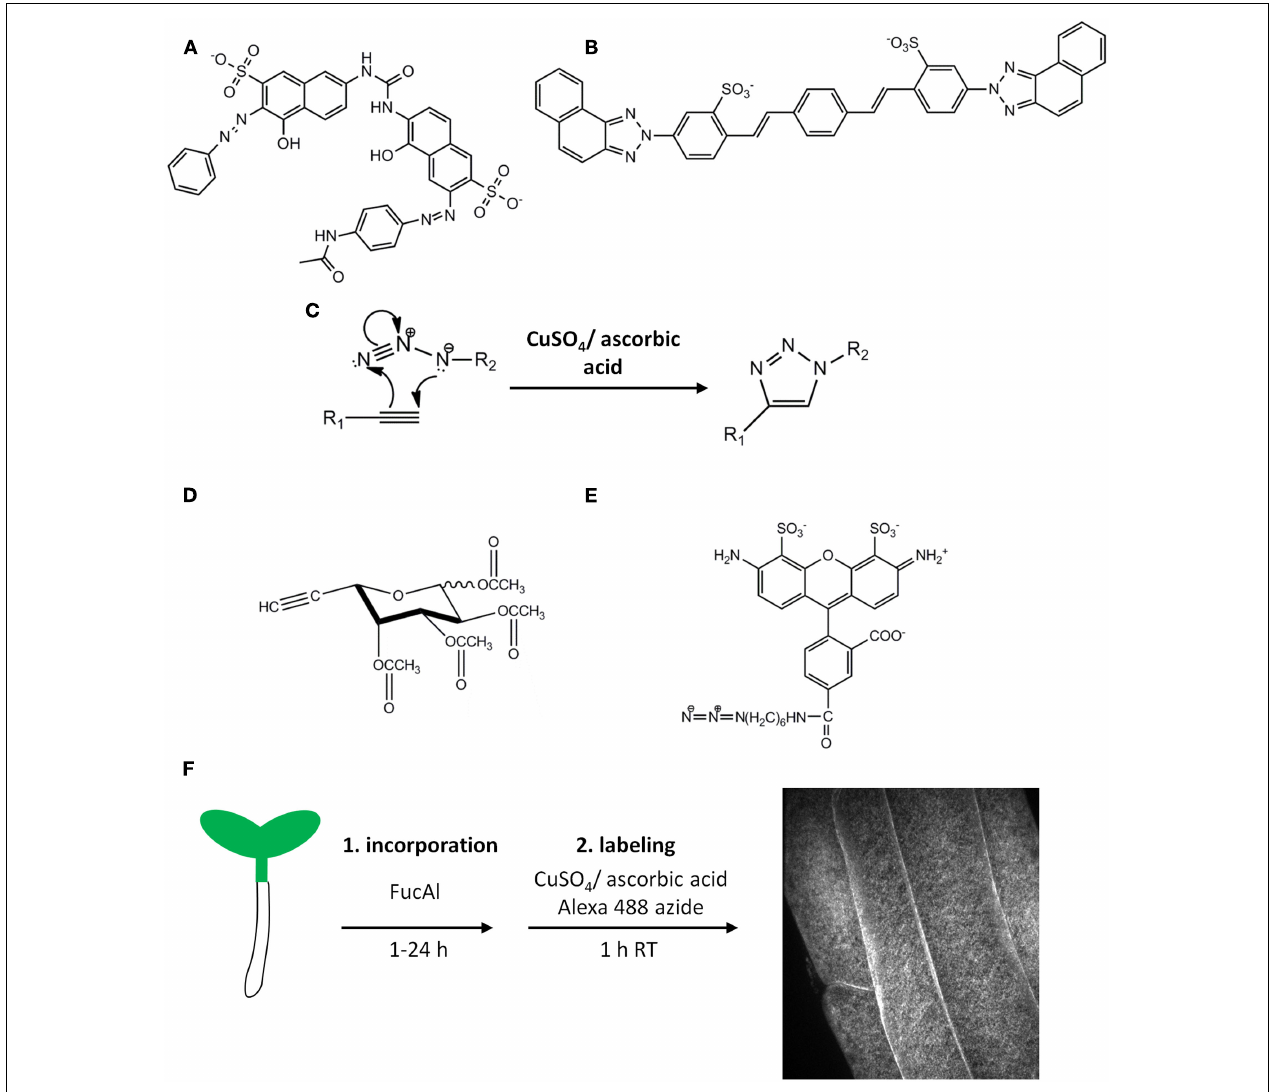
glycans via the action of sugar salvage pathways and cognate glycosyltransferases, producing modified polysaccharides that can be labeled with azido-containing fluorophores by the click reaction.This strategy was used in Anderson et al. (2012) to metabolically label pectins by incorporating FucAl into the root tissue of Arabidopsis followed by copper-catalyzed labeling as shown in (F) . A representative image of root epidermal cells in the late elongation zone after labeling is shown in the right